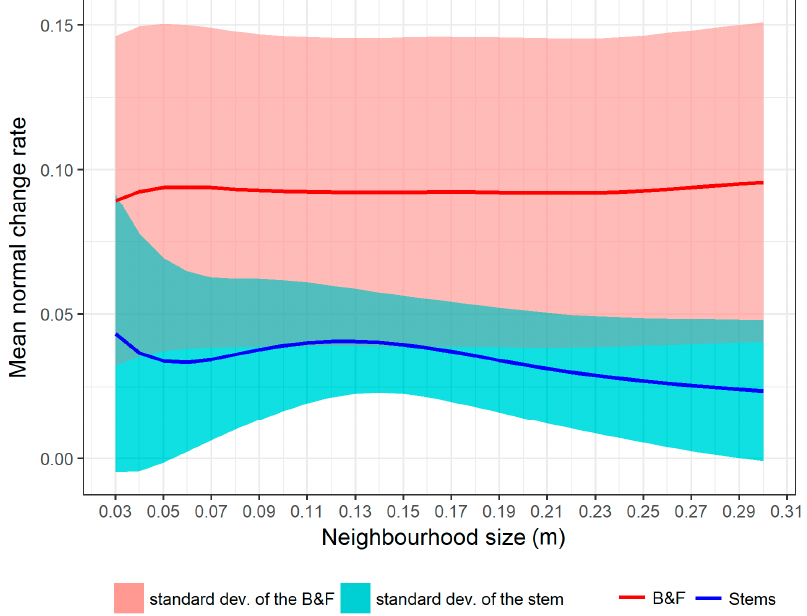
Figure 3. Mean normal change rate (NCR) of stems and branches and foliage (B&F) points from the multi-scan point cloud of the plot 1 with the increasing neighborhood size. The mean NCR on the stems was smaller than B&F. However, they cannot be completely separated by a threshold because of the deviation of the NCR on them.